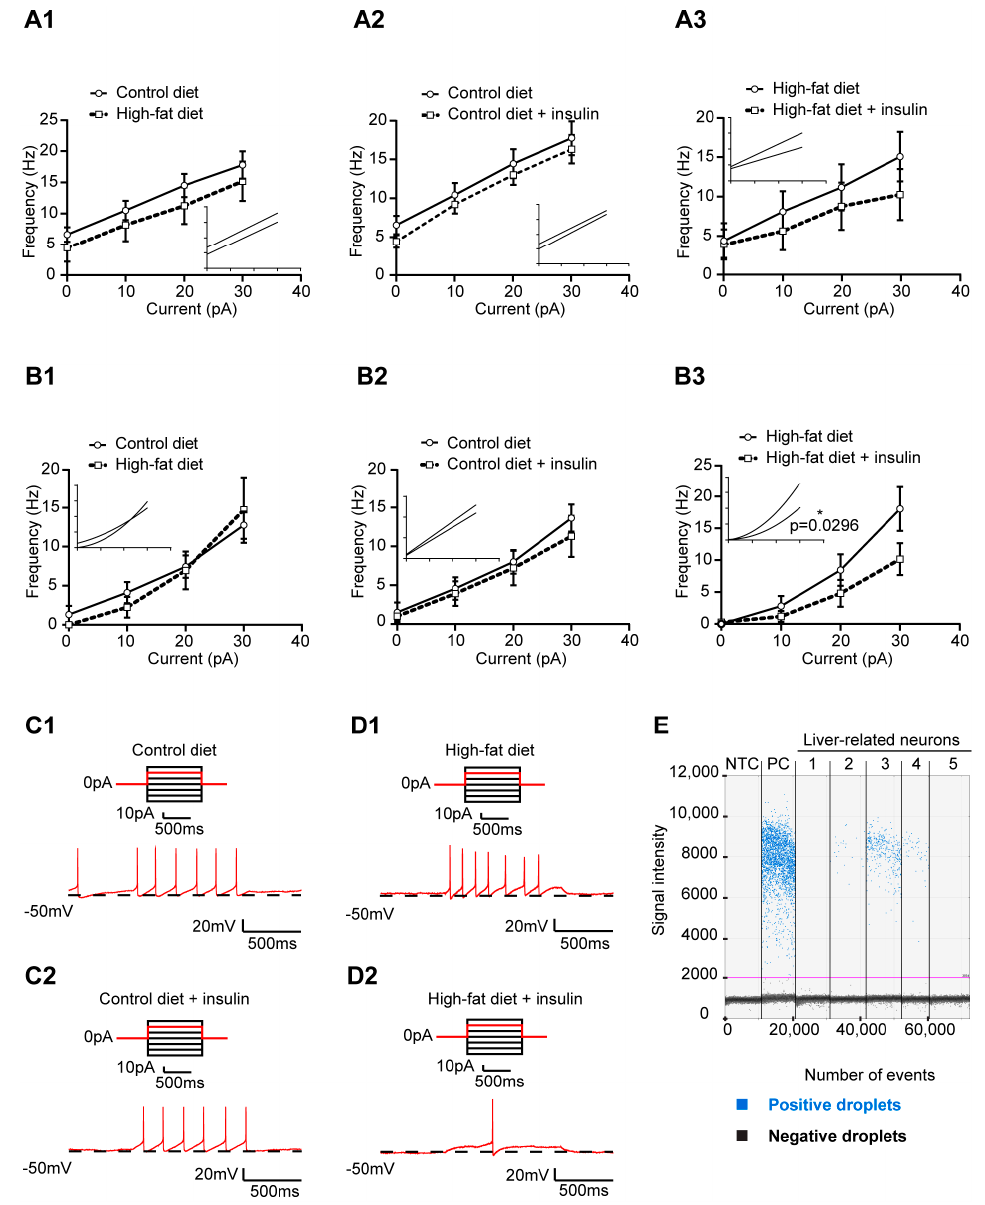
Figure 5. The excitability of liver-related neurons in the VLM/VMM decreased in response to insulin in mice fed with HFD. ( A ): Current–action potential frequency relationship demonstrates that diet ( A1 ) or insulin ( A2 , A3 ) did not have an effect on the excitability of VLM-projecting liver-related PVN neurons. ( B1 ): Diet did not affect the firing rate of pre-sympathetic liver-related neurons in the VLM/VMM. ( B2 , B3 ): Whereas in control mice, insulin did not alter the firing, it suppressed the excitability of liver-related neurons in the VLM/VMM in HFD-fed mice ( B3 ). ( C ) : Representative traces illustrate the firing rate of liver-related VLM/VMM neurons before ( C1 ) and after ( C2 ) bath application of insulin in control mice.( D ): Representative traces illustrate the firing rate of liver-related VLM/VMM neurons before ( D1 ) and after ( D2 ) bath application of insulin in HFD-fed mice. Whereas multiple current steps were applied, only one trace (+10 pA) is shown for better visibility. ( E ): Using droplet digital PCR insulin receptor expression (blue dots) was shown in a subset of liver-related PVN neurons. NTC: non-template control; PC: positive control. * p < 0.05. Then, the e ff ect of insulin was determined on liver-related PVN neurons projecting to the VLM. Insulin did not a ff ect the membrane properties or the frequency of synaptic currents in control or HFD-fed mice (Table 1). Similarly, insulin application did not result in a signi fi cant change of the fi ring rate of VLM-projecting liver-related PVN neurons in